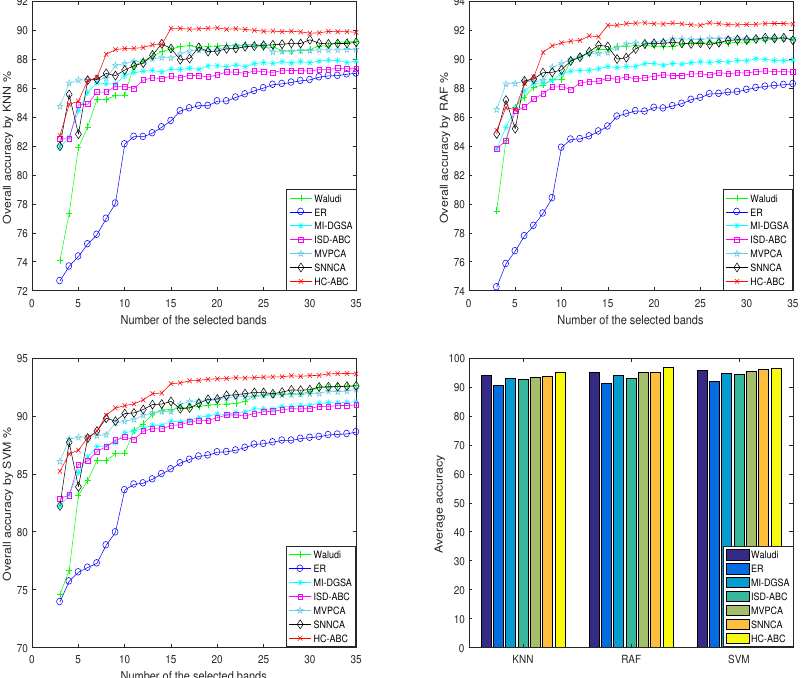
Figure 20. The results obtained by HC-ABC and the 6 comparison algorithms on